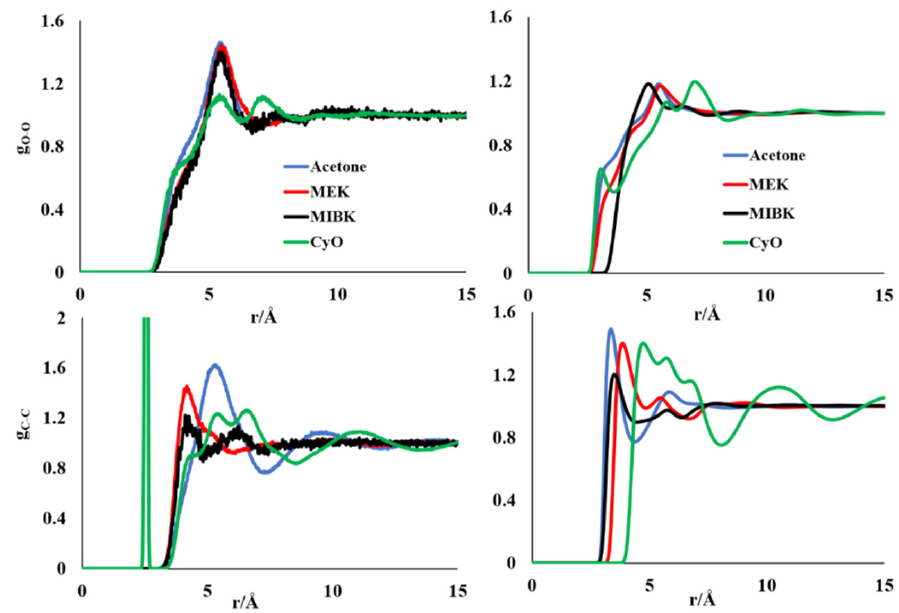
Figure 1. Radial distribution functions obtained from the all-atom MD simulations ( left panels ) and the 3D-RISM-KH calculations ( right panels ) .